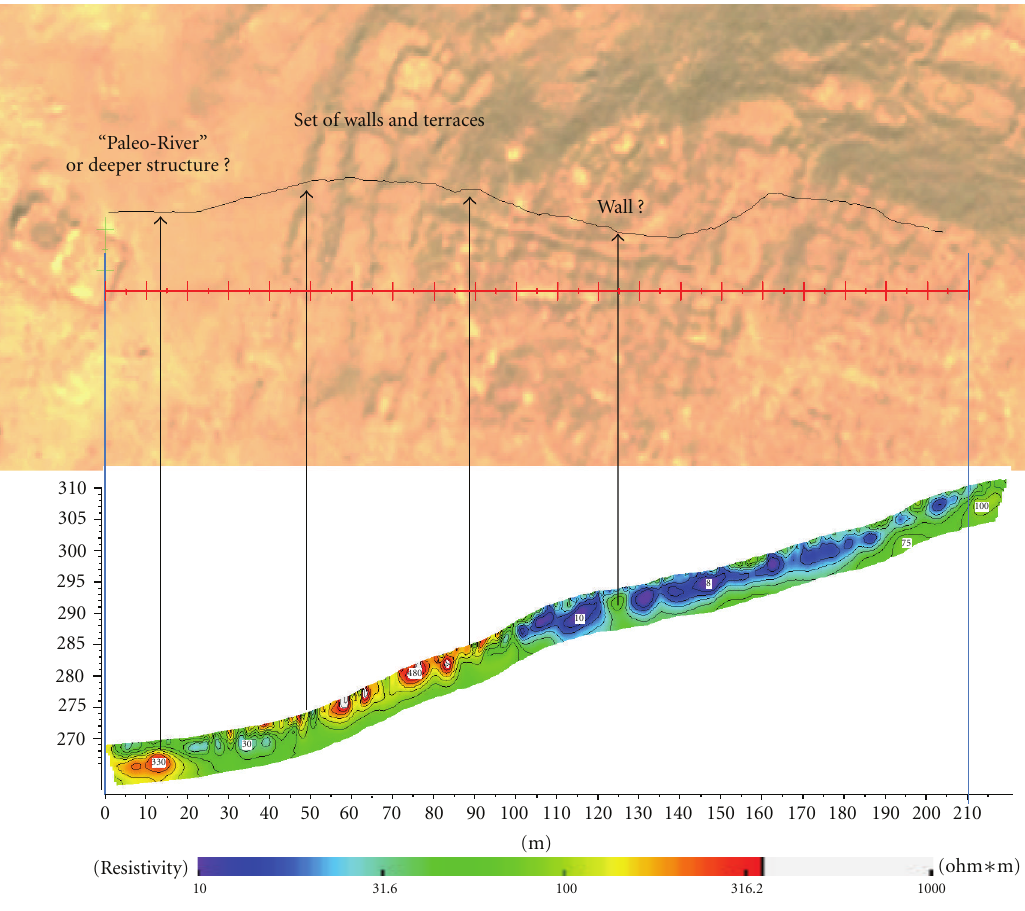
Figure 4: 2D ERT line in the west side of the ancient mound.